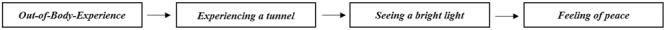
The most frequent sequence of four NDE features (22%) appearing in narratives (N = 27; percentage calculated out of the total amount of narratives containing these four NDE features).